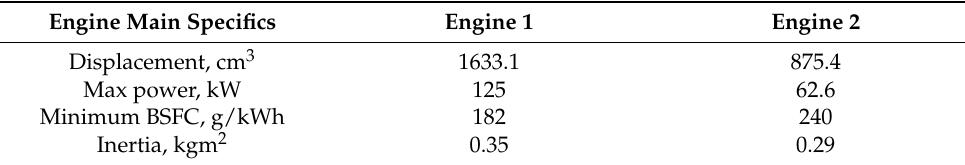
Table 2. Main characteristics of the engines 1 and